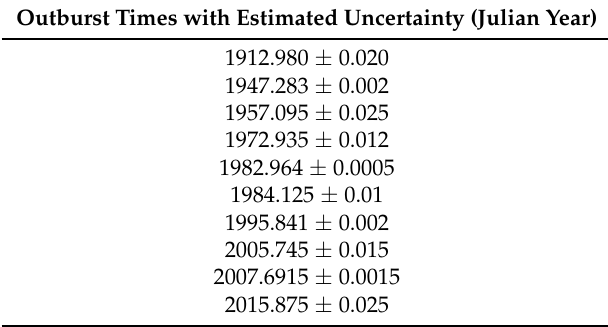
Table 1. Extracted starting times of the well-observed optical outbursts of OJ 287 [9]. ©AAS 2018.